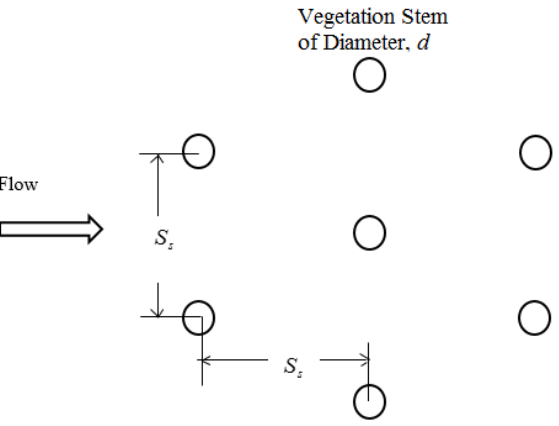
Figure 3. Vegetation stems arrangement.